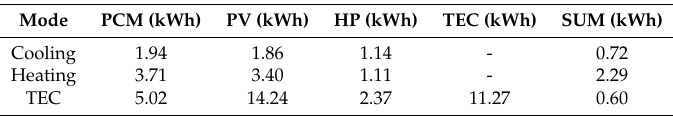
Table 1. Energy balance of the used